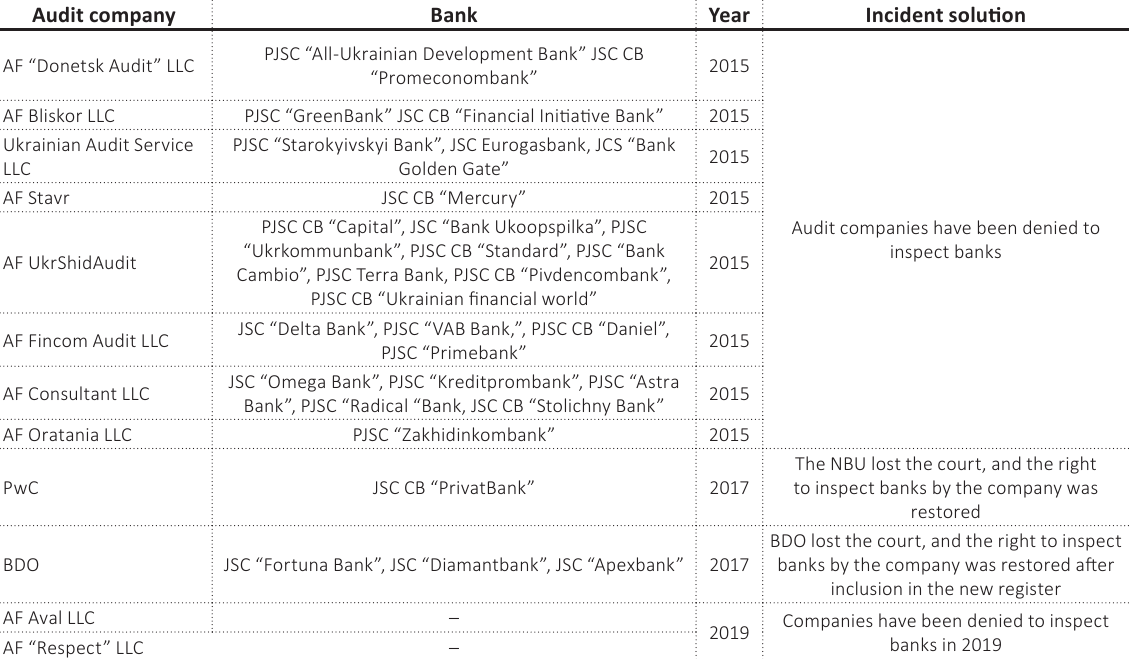
Table 1. Some incidents related to the banks’ audit in Ukraine in 2015–2019